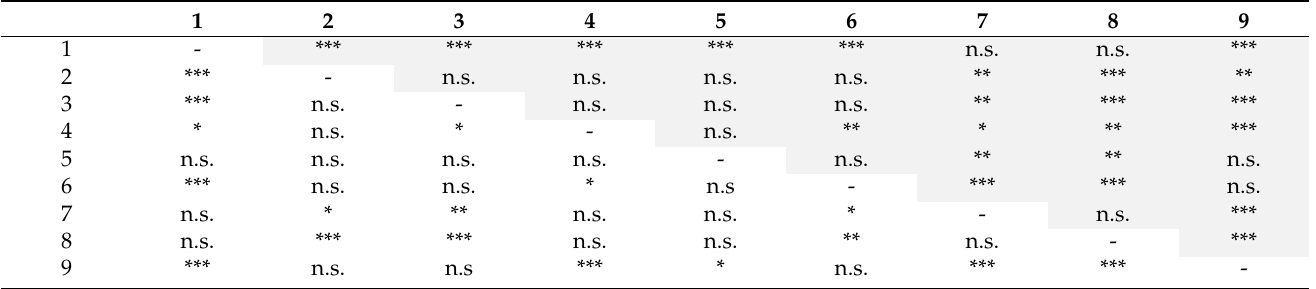
Table 2. Significance levels for pairwise comparison for CS values of pronotum, where * =